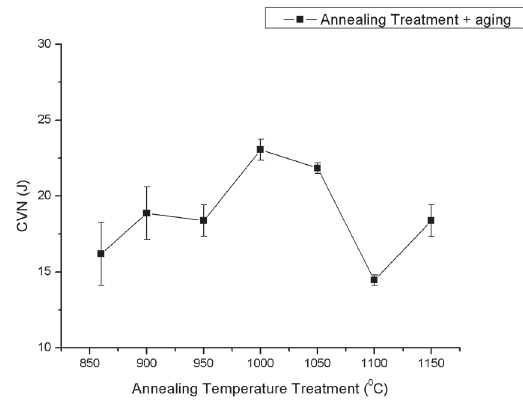
Figure 6: Charpy impact energy for samples solution annealed and aged at 480